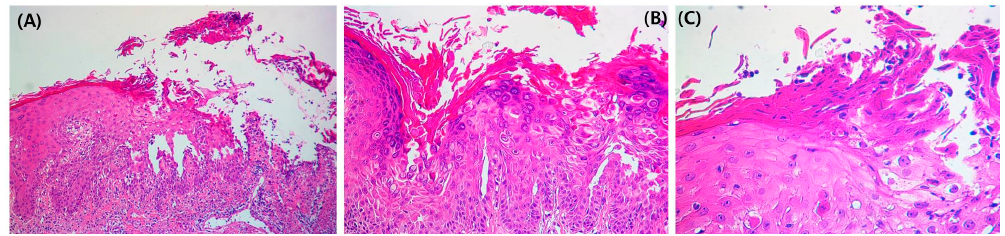
Figure 3. ( A ) Focal acantholysis was present in the suprabasal layer of the erosion area in the epi- dermis (H&E 100×). ( B ) Dyskeratosis and corps ronds, pyknotic nuclei, and a clear perinuclear halo (H&E 200×) were observed in the epidermis. ( C ) Corps grain compressed cells.